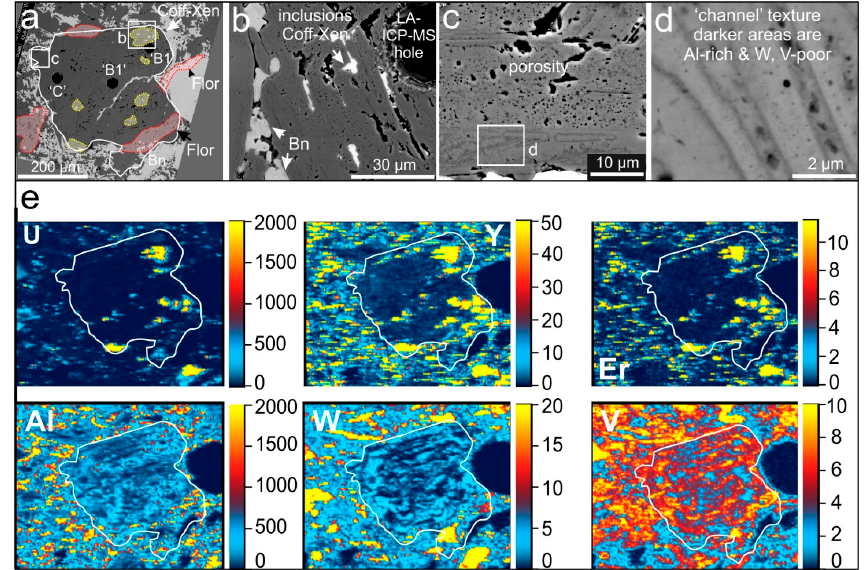
Figure 6. BSE images ( a – d ) showing the textures of coarser, sub ‐ rounded grain of hematite from the same sample as in Figure 5 (aggregate of acicular lamellae). Note the presence of µm to sub ‐ µm size REE ‐ mineral inclusions ( a , b ), as well as the abundance of pores throughout most of the grain ( c ); ( d ) channel ‐ like sub ‐ texture shows a correlation between high concentrations of Al with low concentrations of W and V; ( e ) LA ‐ ICP ‐ MS element maps of reworked, hematite resulting in a depletion of granitophile and HFSE trace elements. Note the correlation between the maps for U, Y and Er, showing the presence of REE inclusions in ( a , b ), as well as the channel ‐ like patterns on the Al, W, V maps correlating with the texture in ( d ) containing micron ‐ scale inclusions of U ‐ and REE ‐ minerals, extensive porosity and chemically ‐ defined channel textures. Concentration scales in counts ‐ per ‐ second (×10 3 ). Measured isotopes: 238 U, 89 Y, 166 Er, 27 Al, 182 W, 51 V.